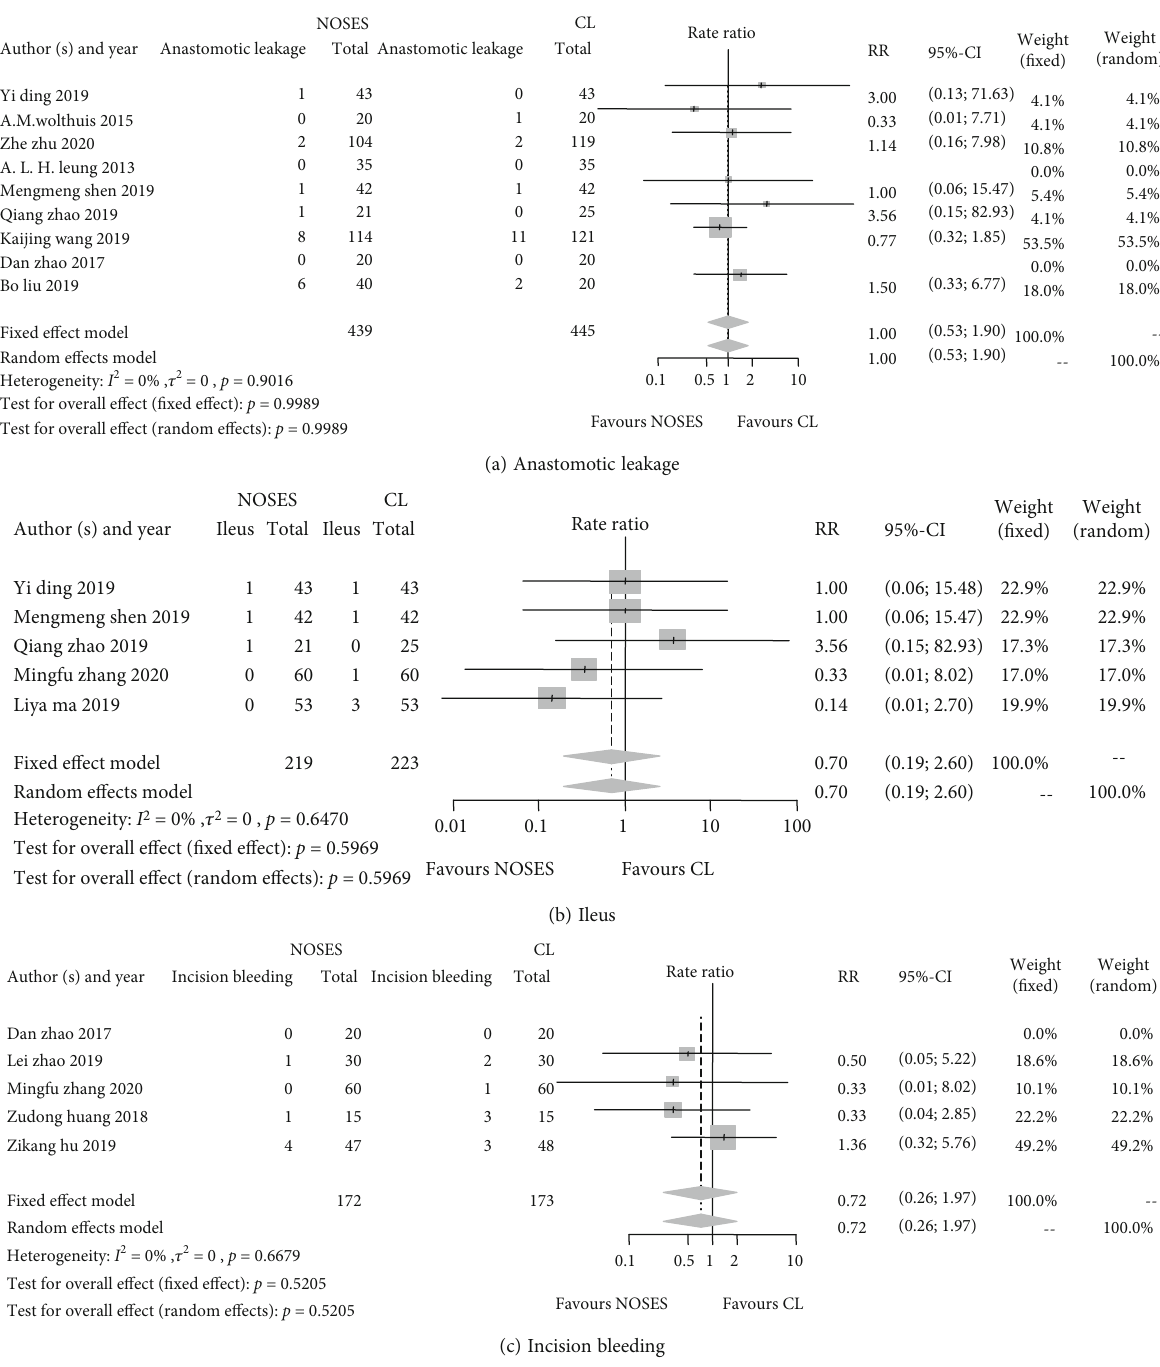
Test for overall effect (fixed effect): p = 0.5205 Test for overall effect (random effects): p =